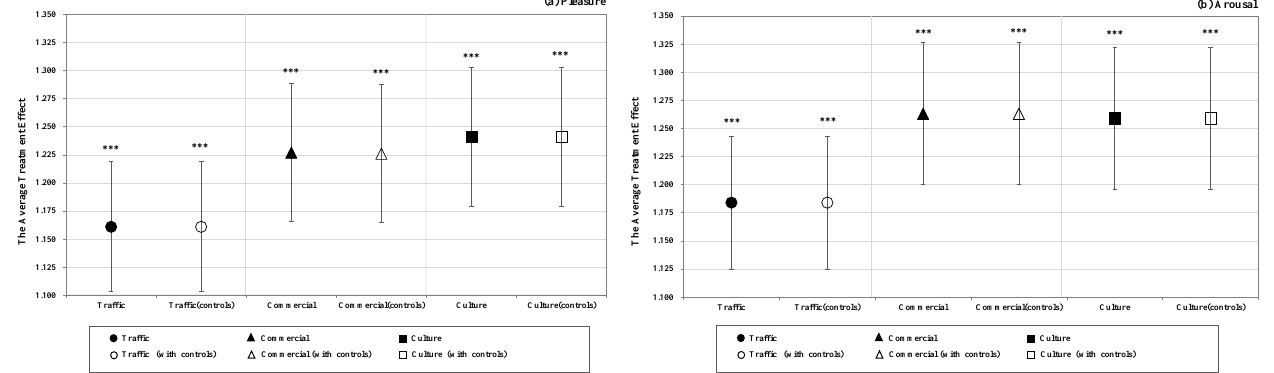
Figure 5. The effect of intervention on tourists’ pleasure and arousal; ( a ) pleasure, ( b ) arousal. Note: Error bars represent 95% confidence interval. *** p < 0.001.